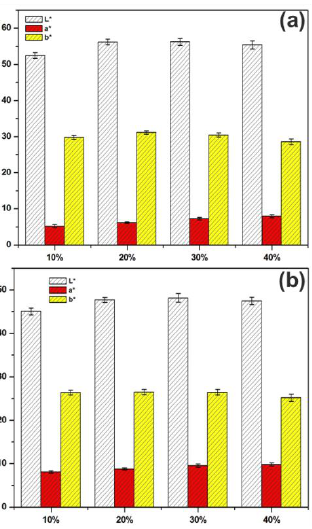
Figure 9. Color measurement of biocomposites with different weight percentage of aspen ( a ) and willow ( b ) wood particles.